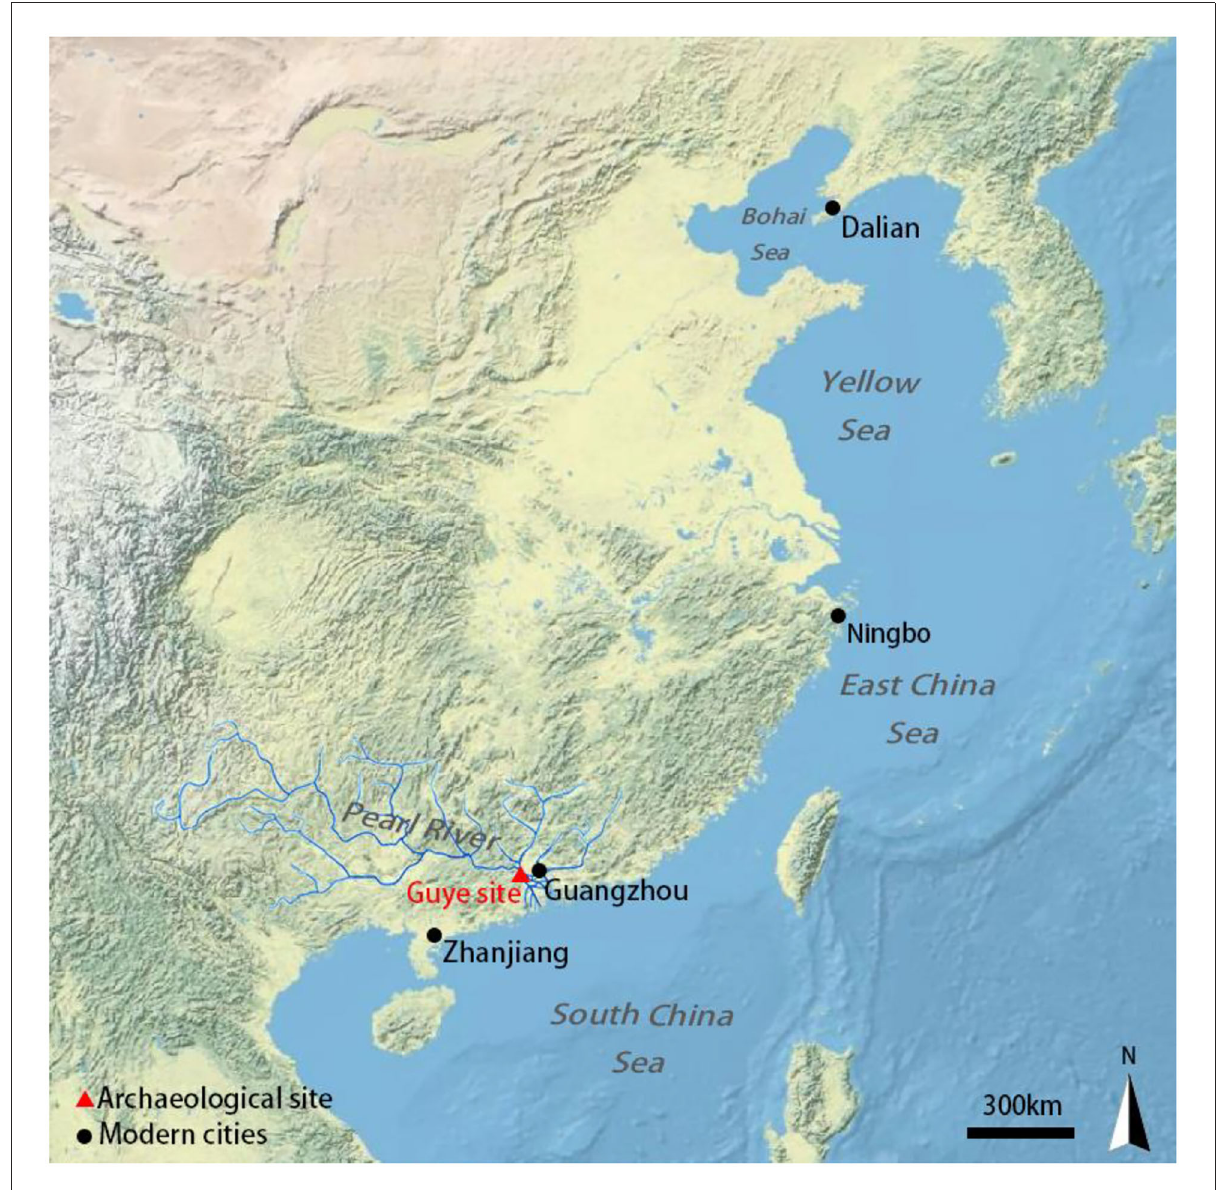
FIGURE2 Location of the Guye site and the comparative collections.